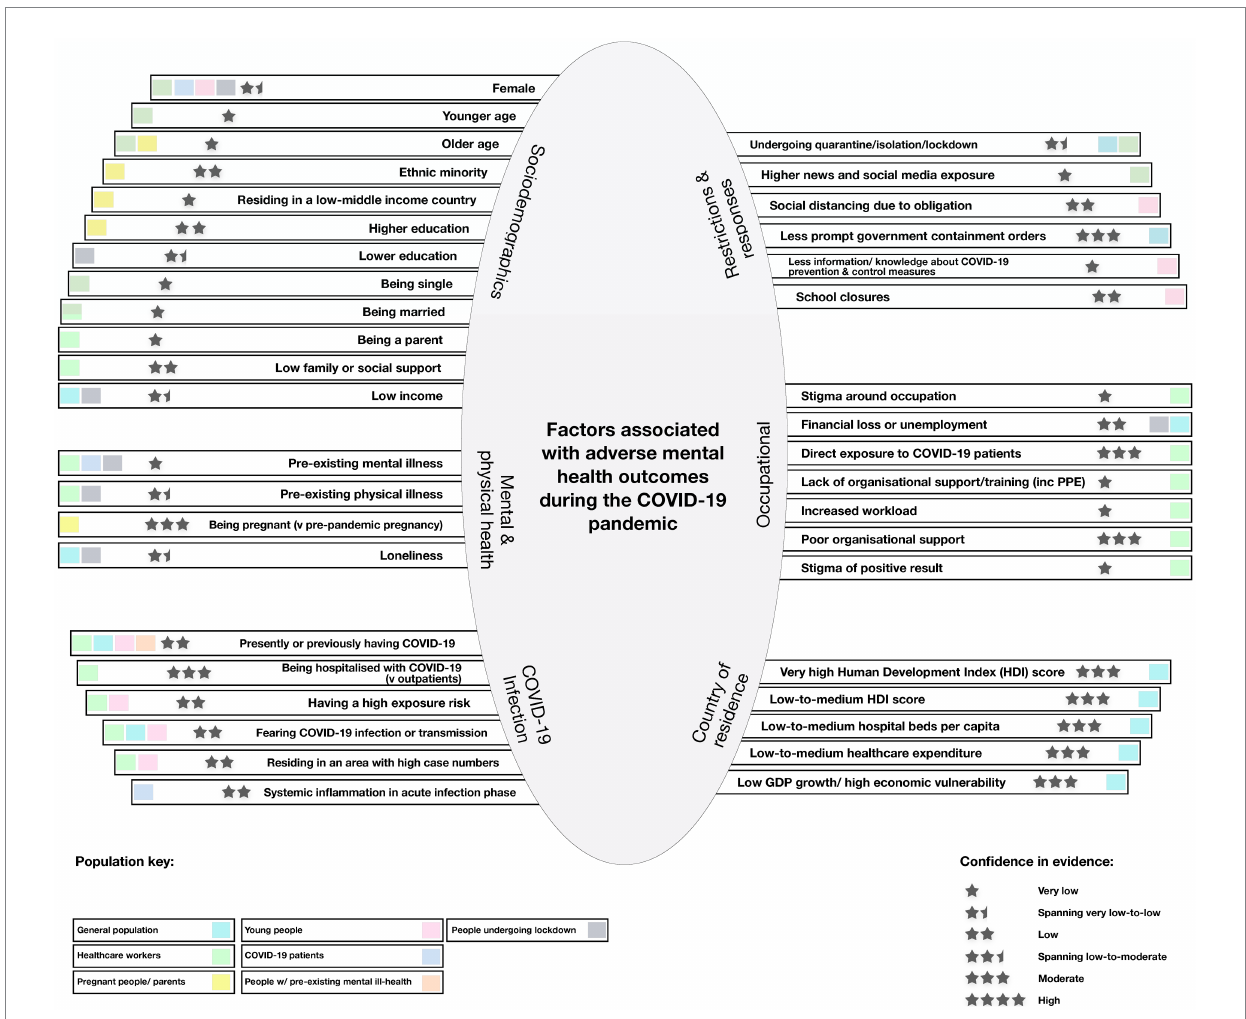
FIGURE 7 Diagrammatic representation of factors associated with adverse mental health outcomes during the COVID-19 period, as identified through narrative synthesis. A diagrammatic representation of the factors associated with adverse mental health in the COVID-19 period, as identified through narrative synthesis. The key has color coding for population group in which the association was investigated. The stars show the level of confidence in the findings, based off the Synthesis Without Meta-analysis (SWiM) method, in addition to the AMSTAR-2 quality